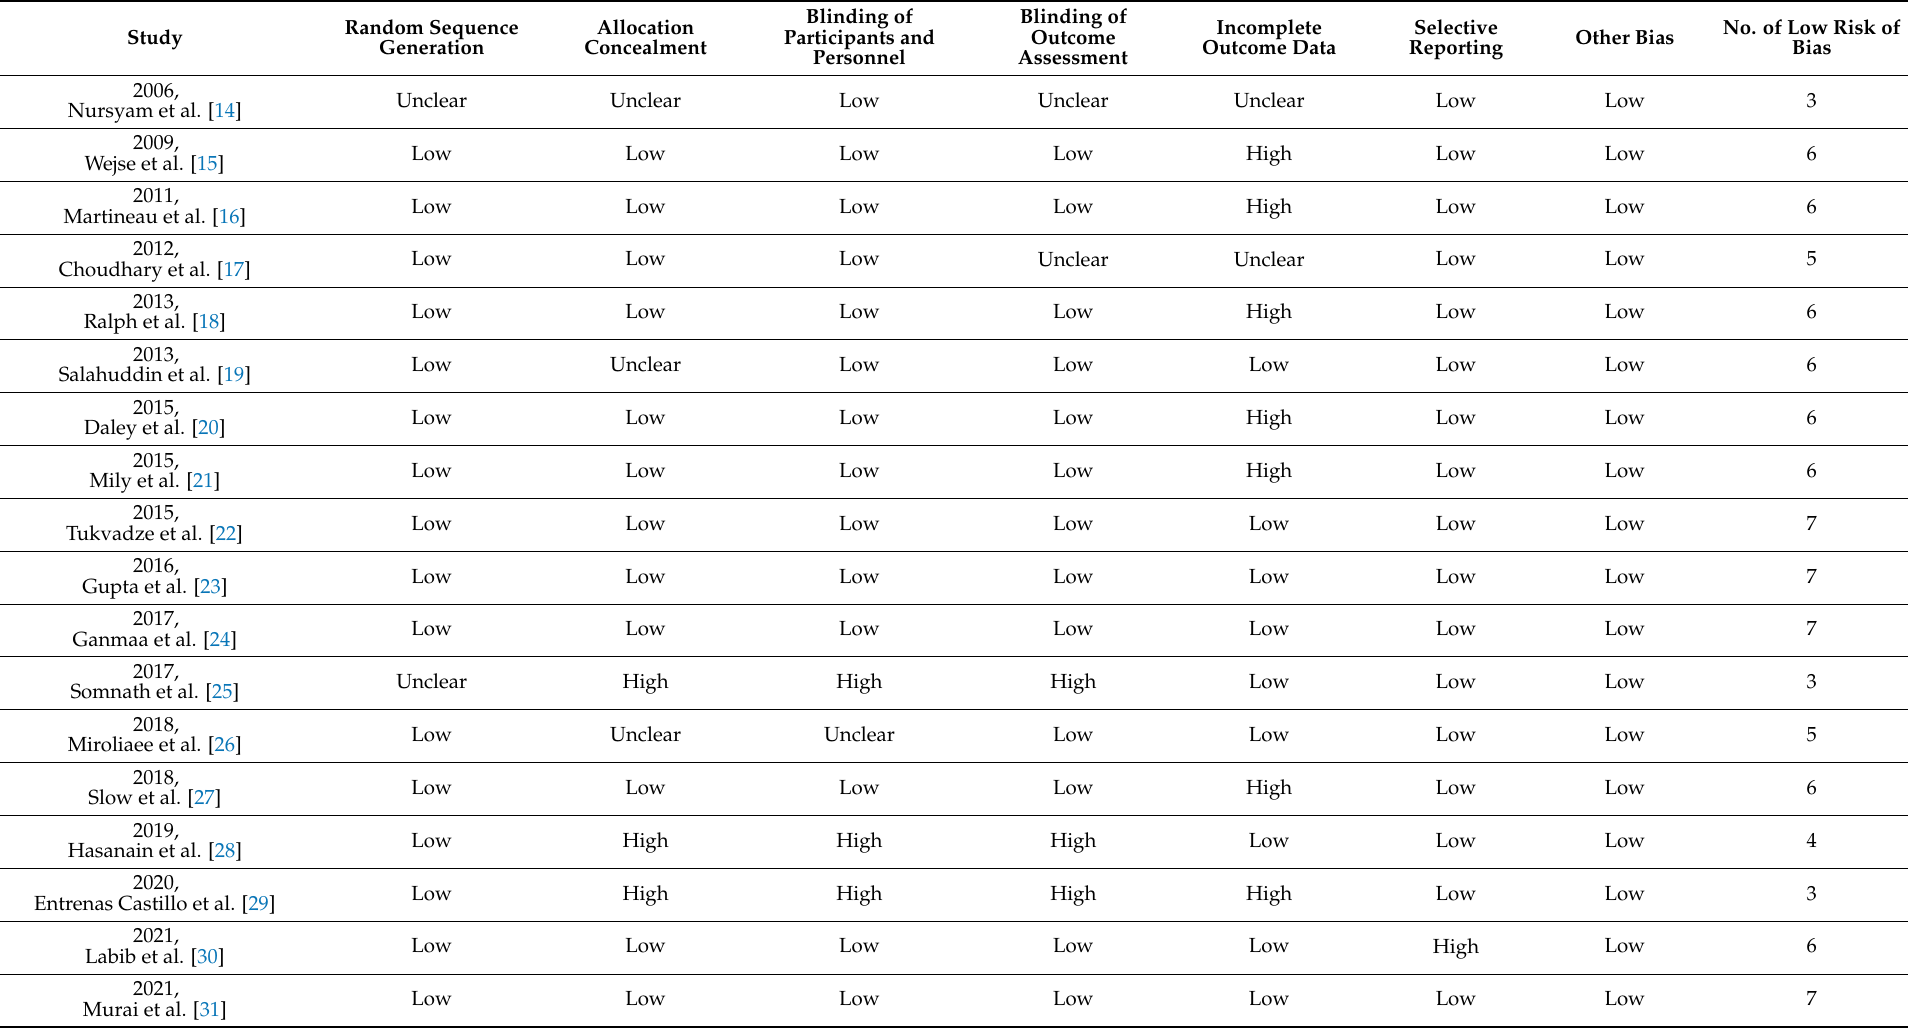
Table 2. Summary of risk of bias assessment for randomized, double-blind, placebo-controlled trials based on the Cochrane Risk of Bias Tool (mean score = 5.5).